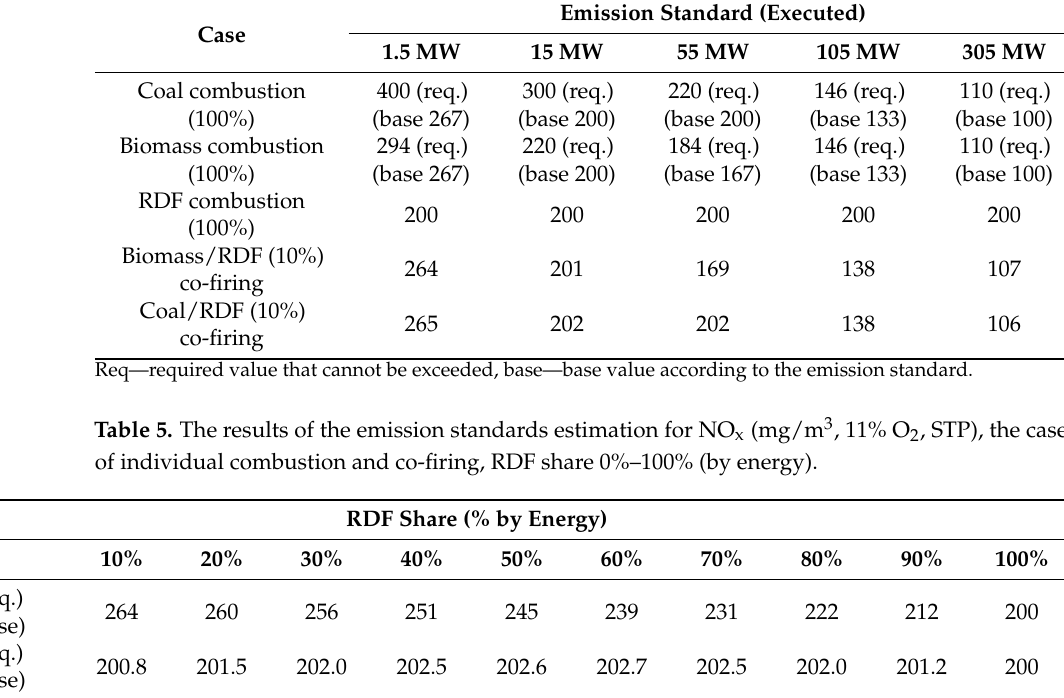
Usually, the real NO x emissions are much less than the emission limits due to the existence of a high-efficient flue gas cleaning system. Table 4. The results of the emission standards estimation for NO x (mg/m 3 , 11% O 2 , STP), the cases of individual combustion, and co-firing of 10% (by energy) share.